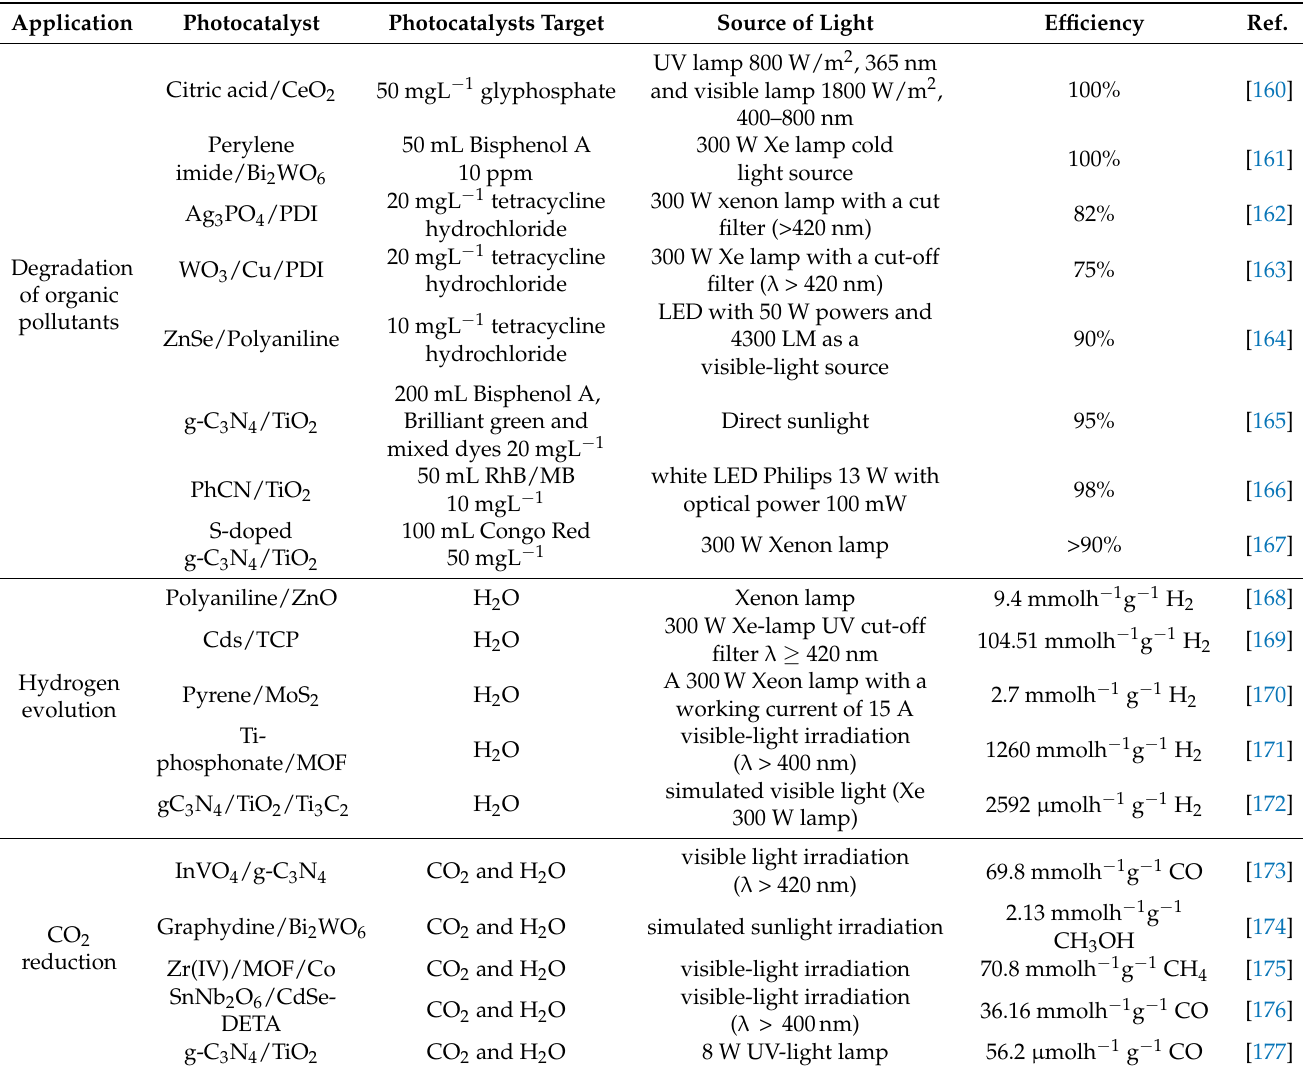
Table 1. Organic-Inorganic photocatalysts and